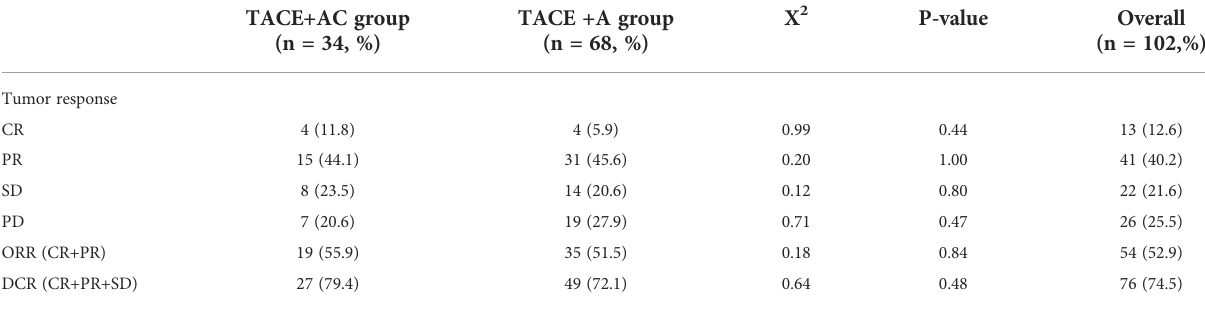
TABLE 2 Tumor response at 1 year between the two groups based on